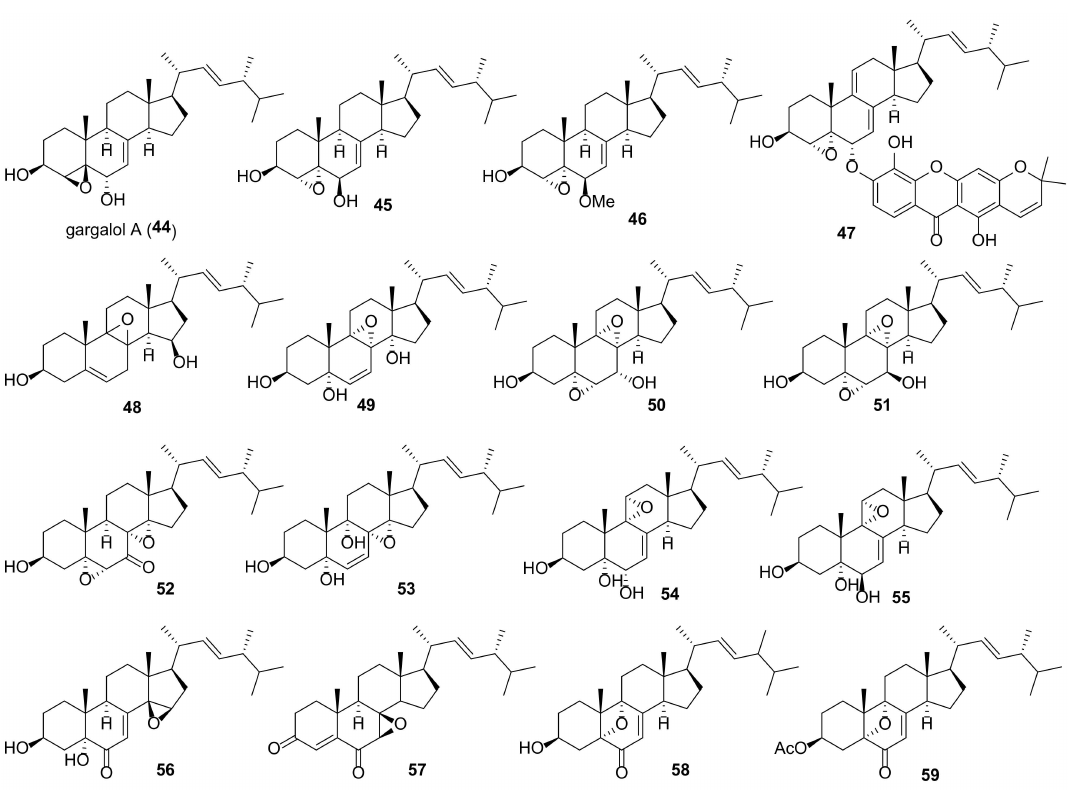
Figure 7. Structures of fungal 5,6-epoxides.